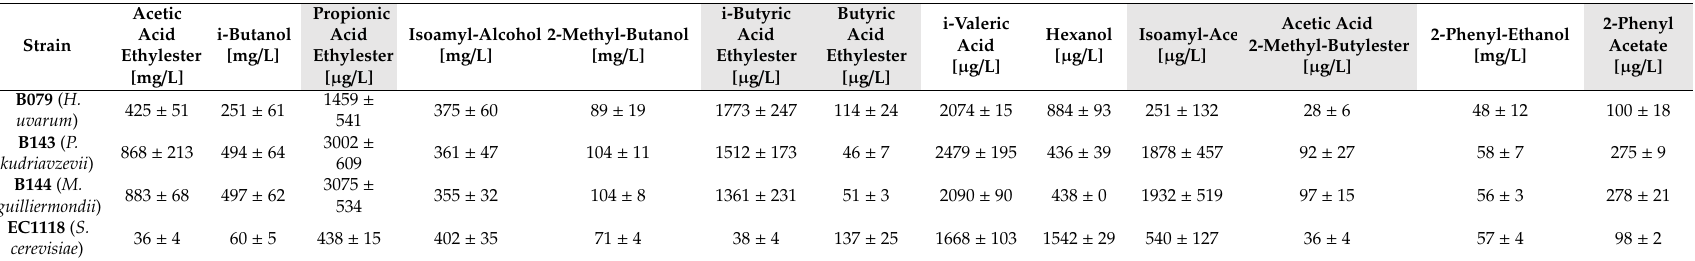
Table 2. Volatile aroma analysis of alcohols and esters.